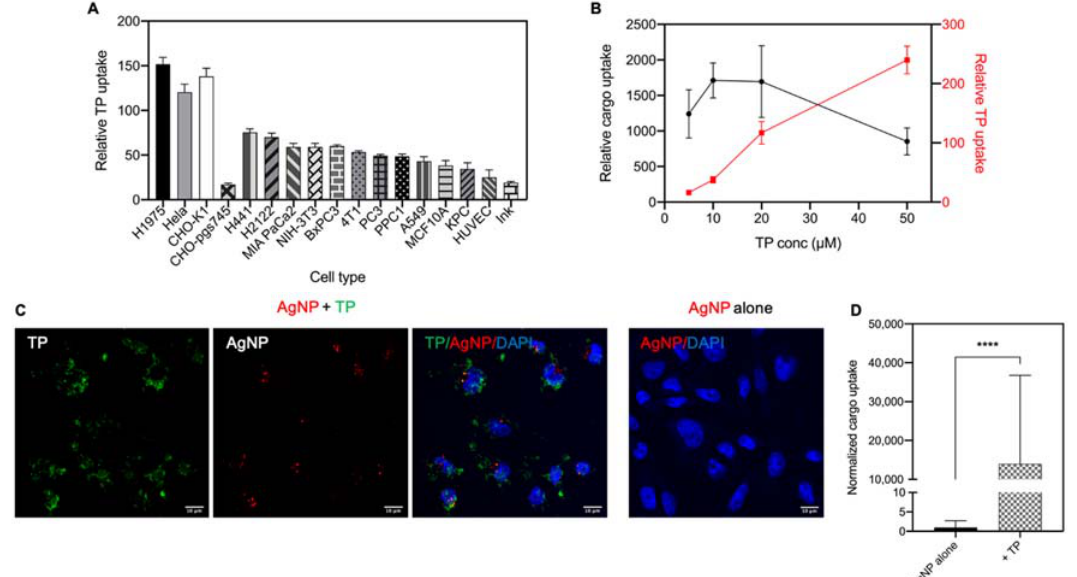
Figure 1. The optimization of TP internalization and induced bystander uptake. ( A ) Quantification of TP peptide uptake in various cell lines. Cells were treated with 10 μ M of FAM ‐ labeled TP peptide (FAM ‐ TP) at 37 °C for 1 h. After washing, the fluorescence intensity of TP peptide per sample was detected and measured by flow cytometry. The median fluorescence value was normalized to that of corresponding cells alone ( y ‐ axis). Error bars, mean ± standard deviation (s.d.) ( n = 3). Statistically significant difference between various cell lines was determined by one ‐ way ANOVA. F (15, 32) = 180.5, p < 0.0001. The uptake in CHO ‐ pgs745 was significantly lower in comparison with that in CHO ‐ K1 when two tailed Student’s t ‐ test was performed ( p < 0.0001). ( B ) Quantification of TP and bystander AgNP uptake by CHO cells at different concentrations of TP. As described in the Methods, CHO cells were incubated with AgNP and TP peptide together at the indicated concentrations (5, 10, 20, 50 μ M). After washing, the fluorescence intensity per sample was quantified by flow cytometry. The median fluorescence intensity of internalized bystander AgNP was normalized to that of cells incubated with AgNP alone (left y ‐ axis, black). Error bars, mean ± standard deviation (s.d.) ( n = 3). Relative AgNP uptake was not significantly different from each other using one ‐ way ANOVA with Tukey’s multiple comparisons test. Left y ‐ axis, relative AgNP uptake (black). Right y ‐ axis, relative TP uptake (red). ( C ) Confocal images of CHO cells after incubation with FAM ‐ TP (green) and bystander AgNP (AgNP ‐ 555, red). Representative images were shown here. Scale bars, 10 μ m. ( D ) Quantification of bystander AgNP uptake by CHO cells. Mean fluorescence intensity of AgNP ‐ 555 obtained from three independent experiments ( n = 3) through Image J software was normalized to that of AgNP alone group ( y ‐ axis). Values shown here were mean ± s.d. There was a statistically significant difference between AgNP alone group and TP group as determined by two tailed Student’s t ‐ test. **** p < 0.0001.